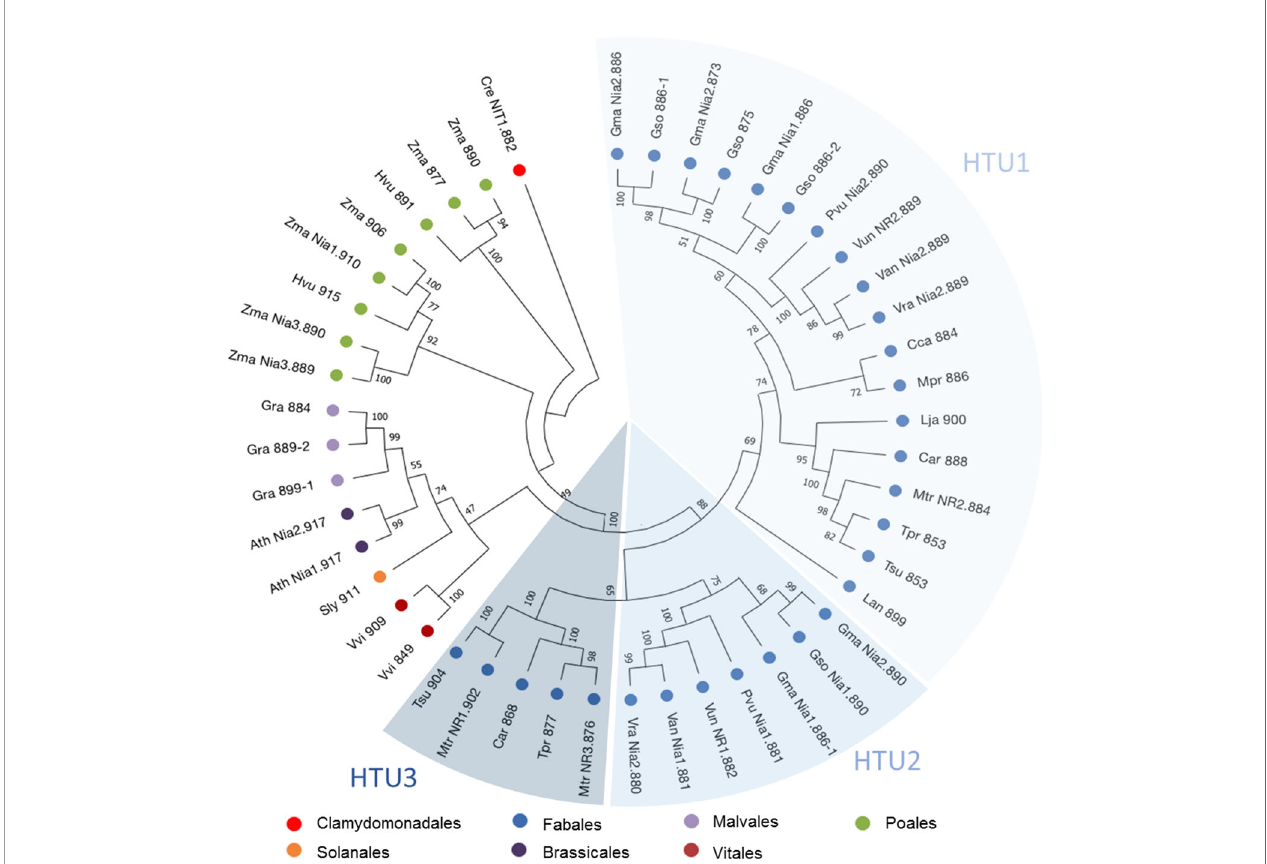
FIGURE 1 | Phylogenetic tree of NR protein sequences. 47 nitrate reductase sequences from model plants or belonging to the Fabaceae family were used in this analysis. The tree was inferred by maximum likelihood (ML) with MegaX (Kumar et al., 2018). Percentages displayed next to each branch represent the number of tree replicates in which the associated taxa were assembled together when performing 1,000 bootstraps. The lengths of the branches do not represent a phylogenetic